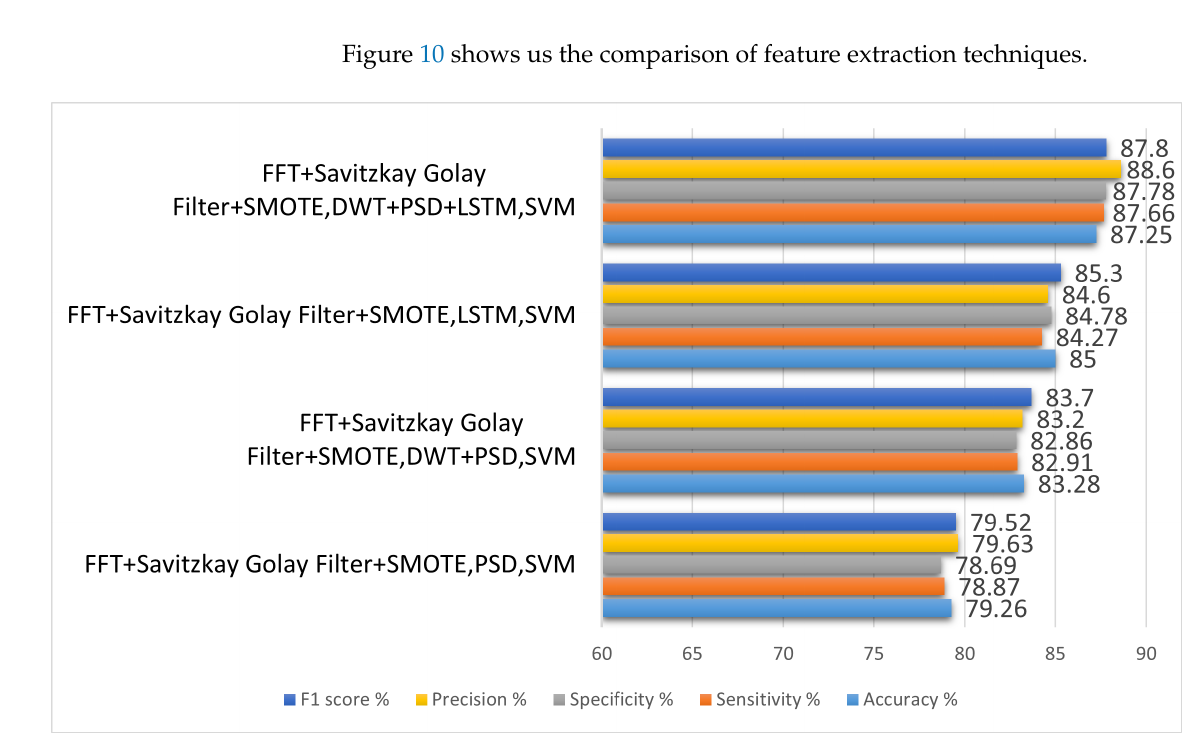
Figure 10. Analysis of different feature extraction techniques in proposed